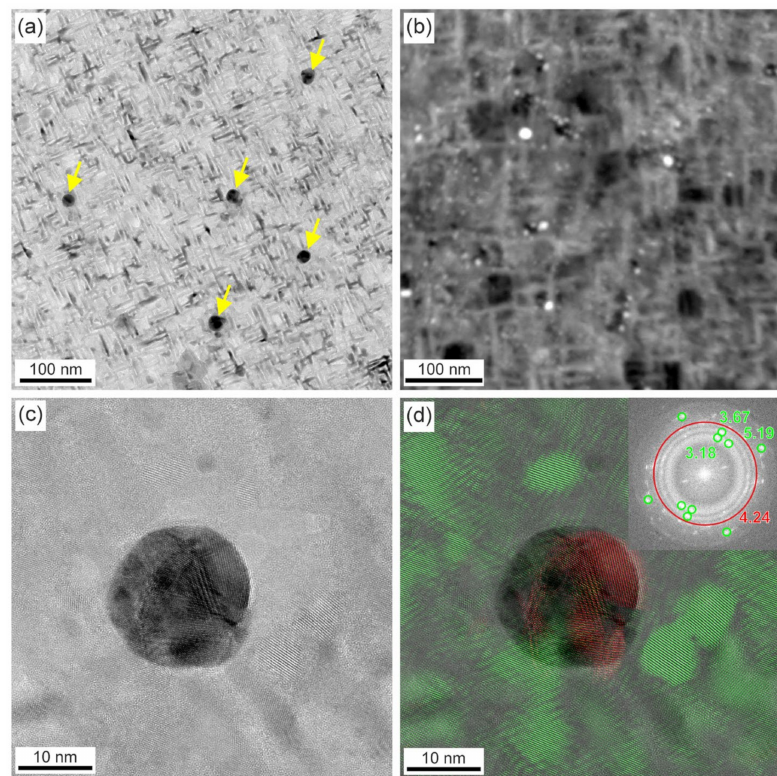
Figure 5. S/TEM results of the CaF 2 containing Ag NPs deposited at a target–orifice distance of 60 mm. ( a ) Low-magnification BF–TEM image, ( b ) low magnification STEM/HAADF image, ( c ) HRTEM image of a single Ag NP showing its polycrystalline form, ( d ) HRTEM image overlaid with mapped CaF 2 in green and cubic Ag in red (FFT inserted with the corresponding spatial frequencies